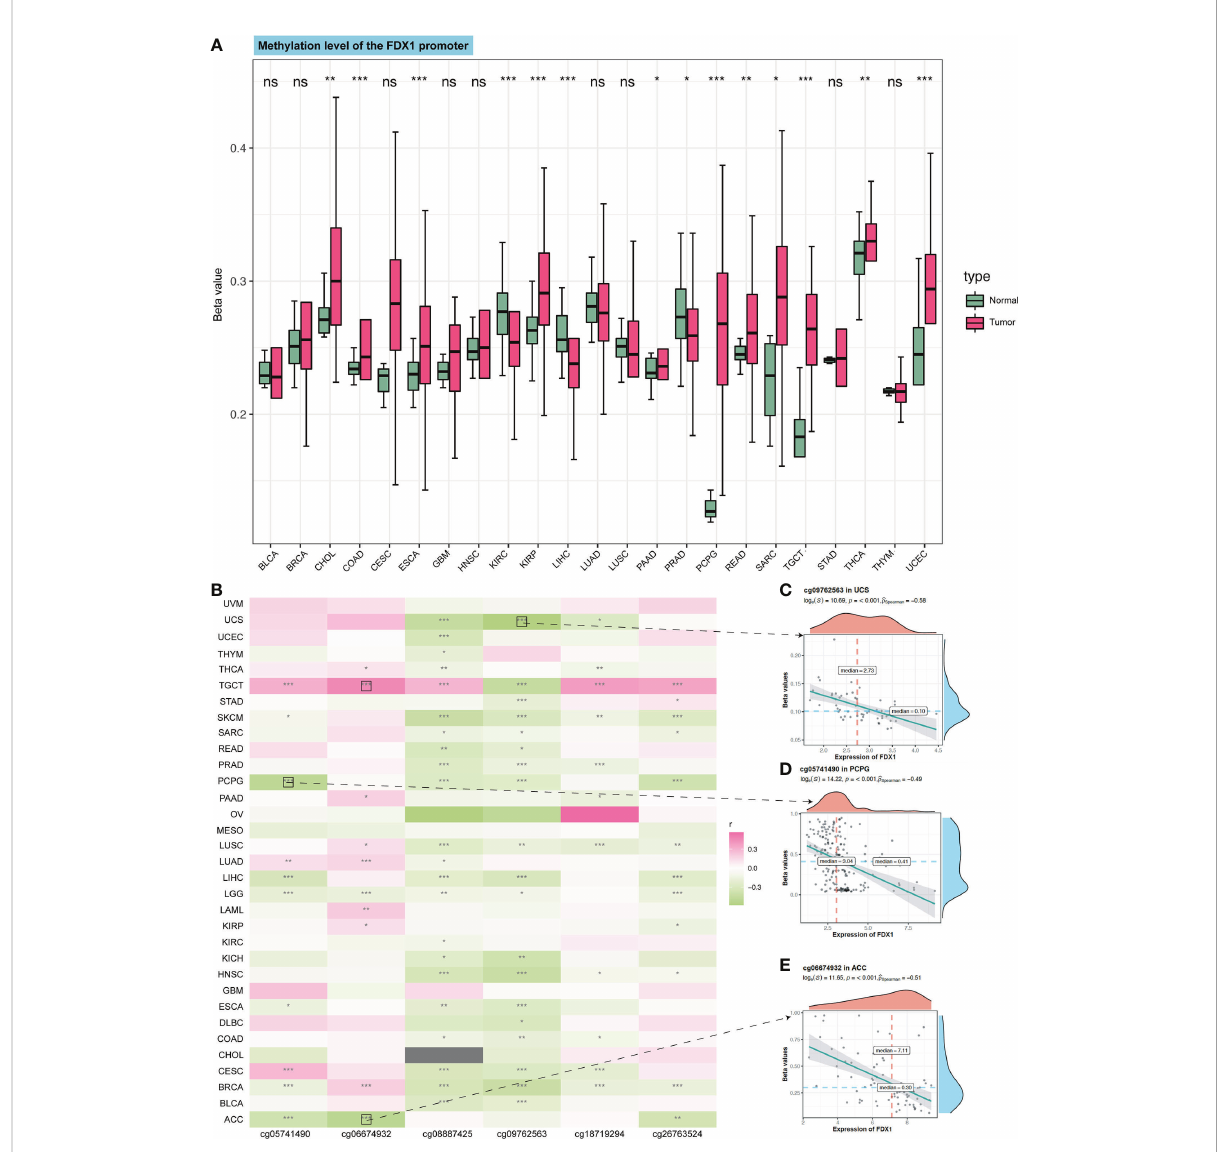
FIGURE 2 Methylation of the FDX1 promoter and correlation between methylation probes and the FDX1 expression. (A) Methylation beta value of the FDX1 promoter in tumors and normal tissues. (B) Correlation between the FDX1 expression and six FDX1 promoter methylation probes. The correlation with the highest r value and p < 0.001 was marked with black boxes. (C – E) The spot correlation plot between the methylation of probes and the FDX1 expression in UCS, PCPG, and ACC. ns, not signi fi cant, p ≥ 0.05; *p < 0.05; **p < 0.01; ***p <